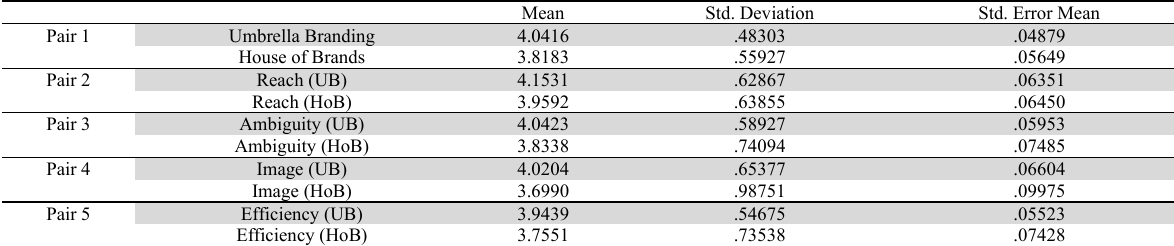
Paired Sample test